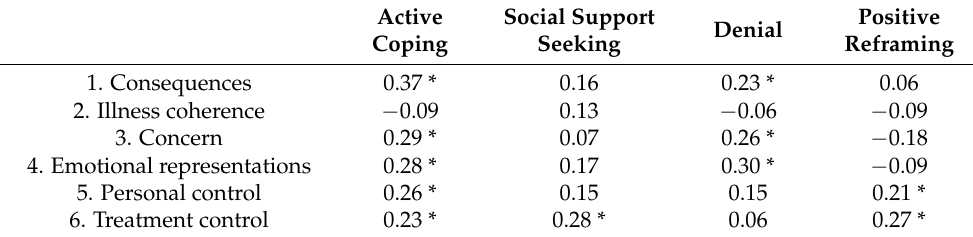
Table 3. Associations of illness representations and coping strategies.